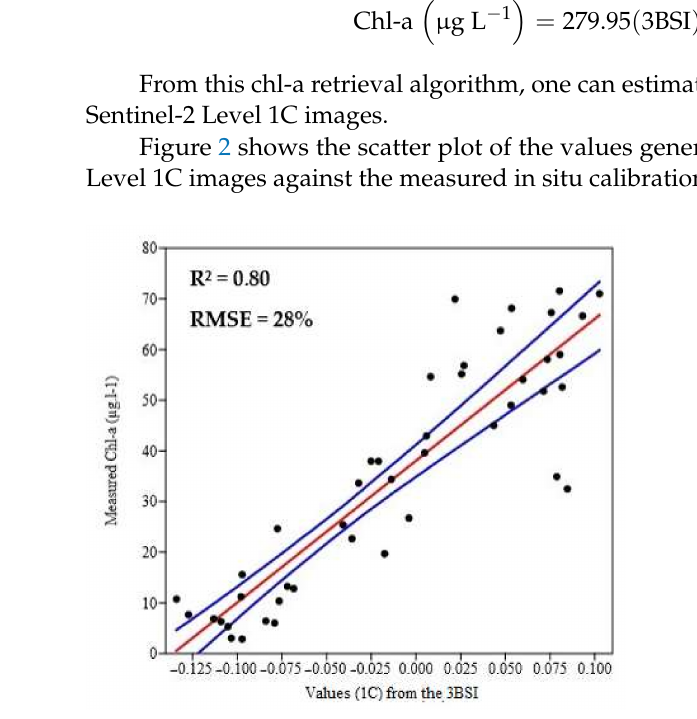
Figure 2. Relationship between the measured in situ chl-a, for the samples considered in the cali- bration dataset, and the values generated by the three-band spectral index (3BSI) for the Sentinel-2 Level 1-C image datasets. The red line represents the regression model calculated using the bootstrap resampling technique. Blue lines indicate two RMSE estimates of